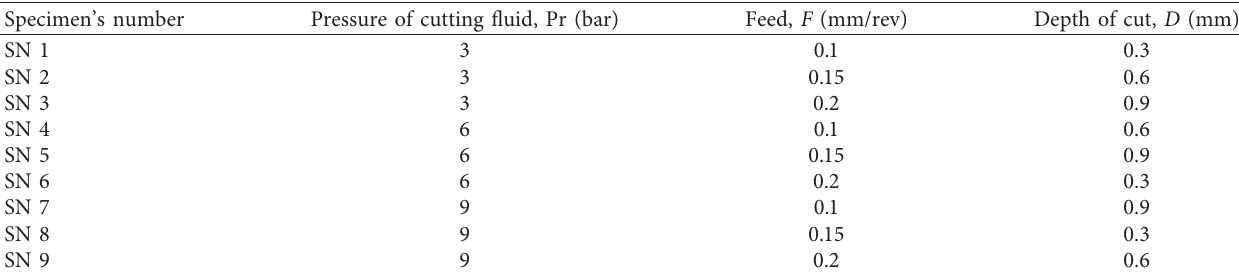
Table 2: Input parameters variation as per the L9 method.